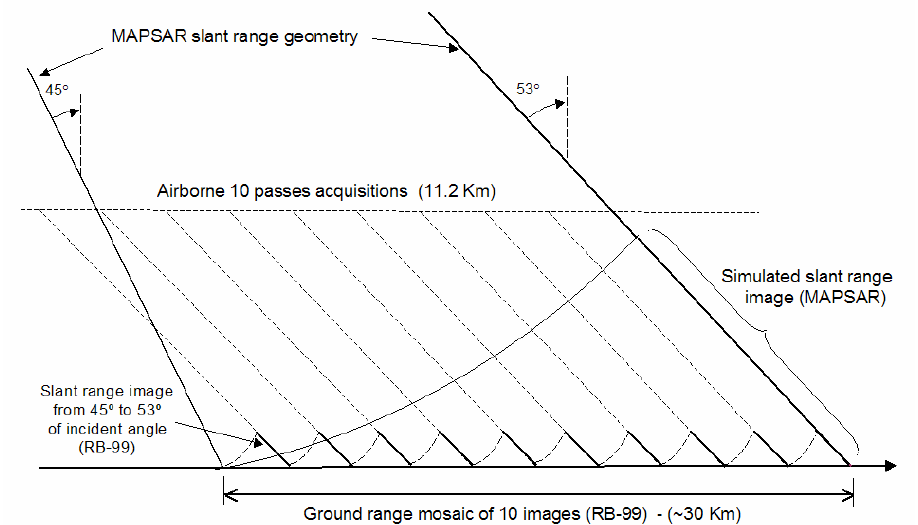
Figure 4. Slant range geometry for the spaceborne MAPSAR